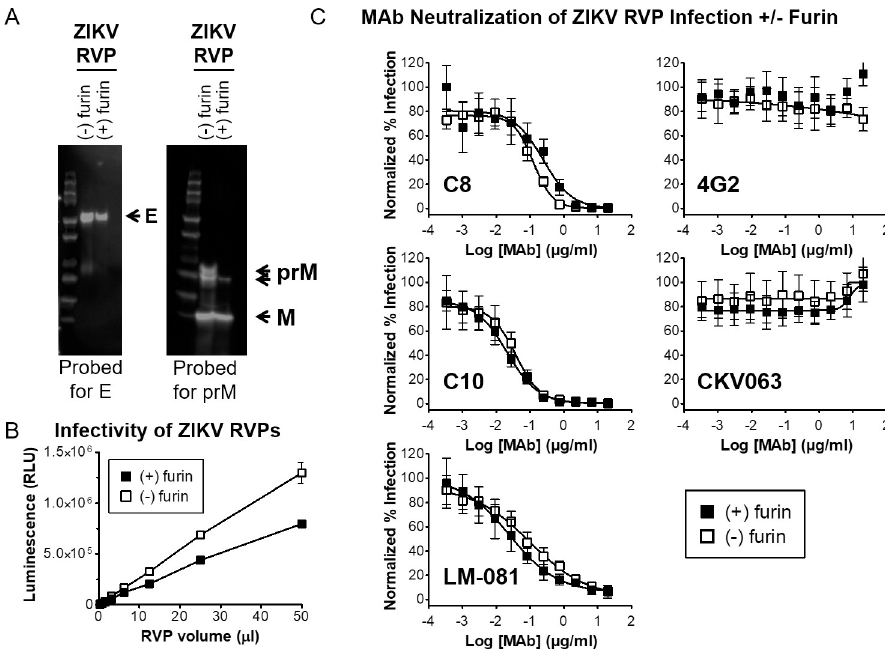
Fig 7. Control of ZIKV RVP maturation state. (A) Western blot showing maturation state of ZIKV RVPs produced in the absence or presence of transfected human furin. (B) Infectivity of ZIKV RVPs produced under normal conditions or in the presence of transfected furin. Each data point is the mean of 2 wells, error bars represent the range. (C) Neutralization of infectivity by ZIKV RVPs produced under normal conditions in the absence or presence of transfected furin. ZIKV RVPs were incubated with serial dilutions of MAbs C8, C10, LM-081, 4G2, and CKV063. Each data point represents the average of 8 wells; error bars indicate SD.